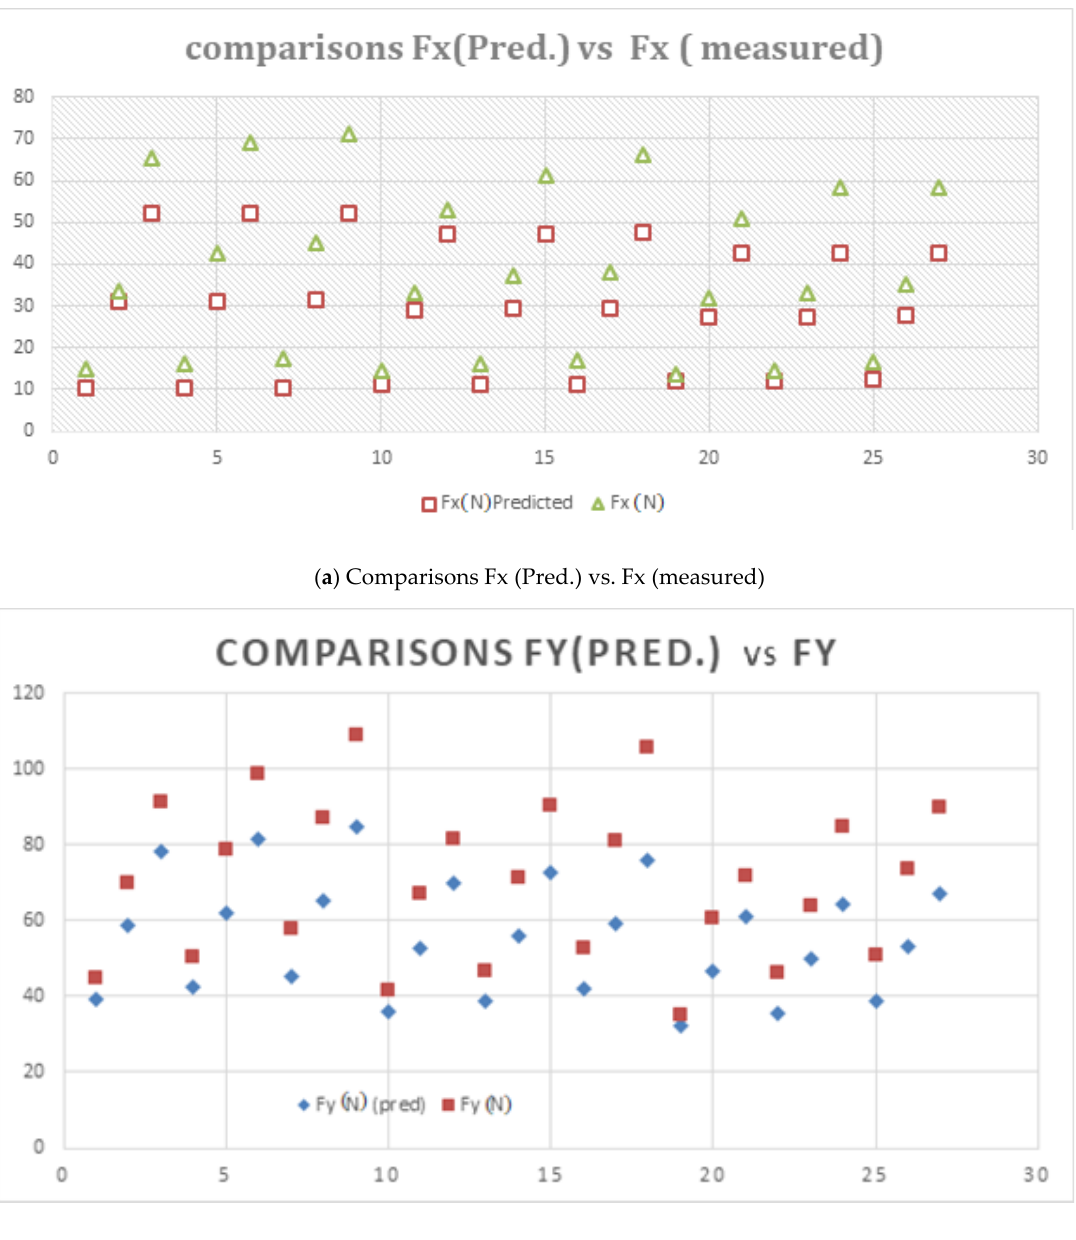
( c ) Comparisons Fz (Pred.) vs. Fz (measured) Figure 11. Comparisons of predicated and measured values. 4. Conclusions In the current study, a turning operation was performed on an EN36B steel work-billet with a tungsten carbide tool. The machining variables, i.e., the cutting speed and feed and depth of cut, were optimised to reduce the wear rate. The concept of re- sponse-surface methodology was used for designing this experiment. ANOVA and linear regression analysis were performed to linearly fit the experimental data. It was con- cluded that the cutting-force components (Fx, Fy and Fz) are governed by the depth of